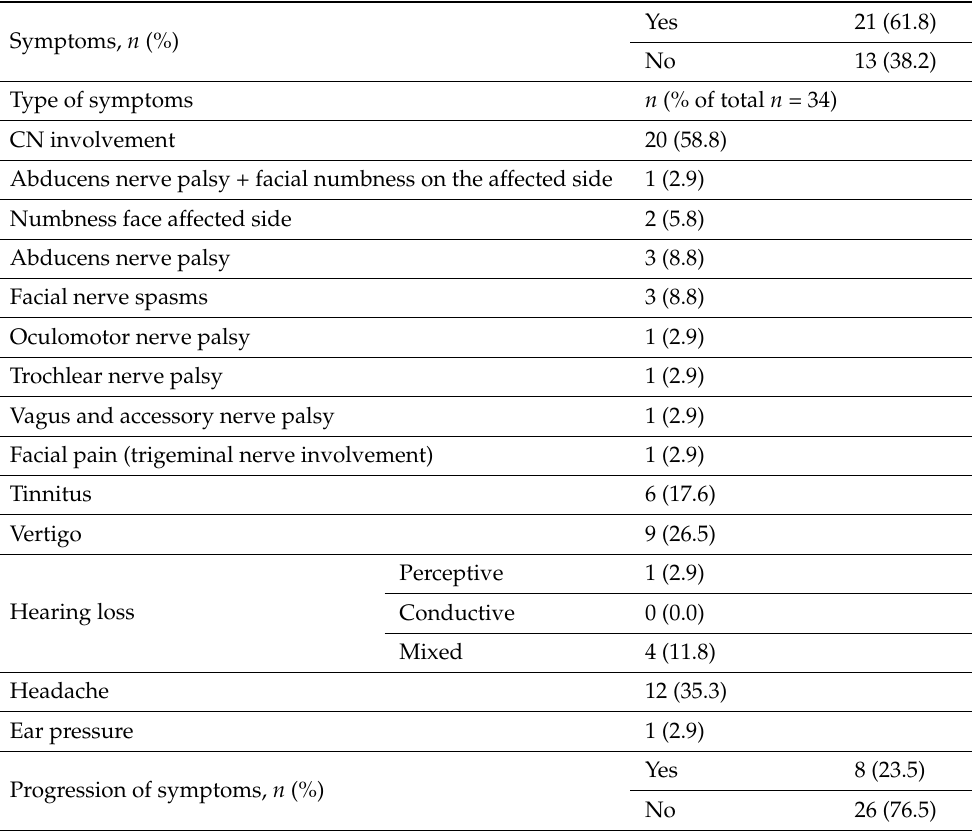
Table 2. Reported symptoms and clinical features.